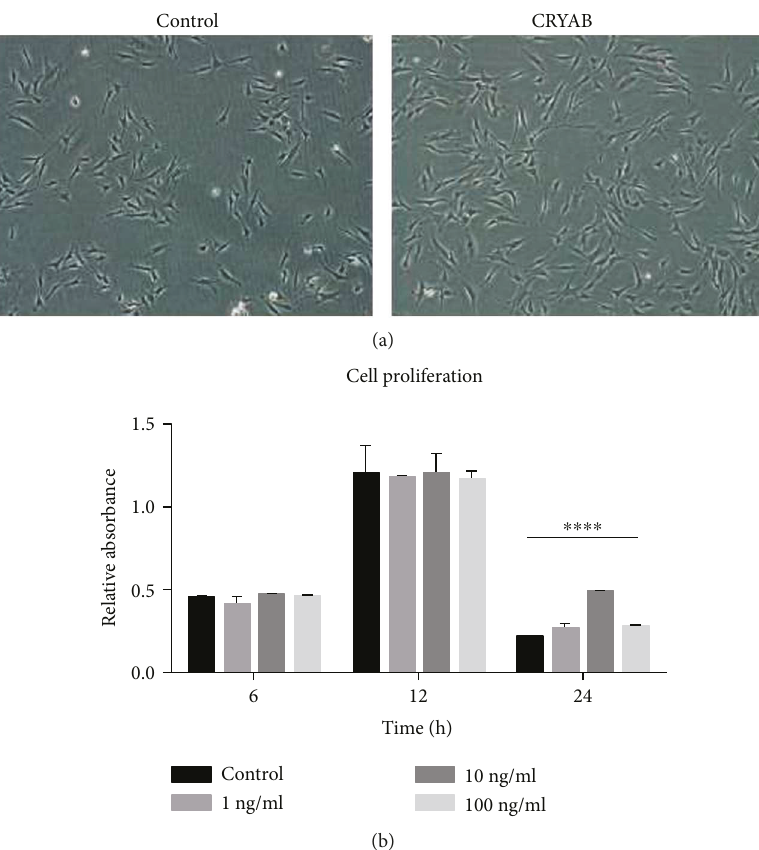
Figure 1: (a) Light micrographs of the TM cells treated with CRYAB (TM cells grown alone served as the control, 100x magni fi cation). (b) CRYAB induced proliferation in TM cells. TM cell proliferation was determined with CCK8 after 6h, 12h, and 24h incubation with 1ng/ml, 10ng/ml, and 100ng/ml CRYAB. The 10ng/ml CRYAB for 24 h treatment increased TM cell proliferation. ∗∗∗∗ p < 0 0001 versus the untreated